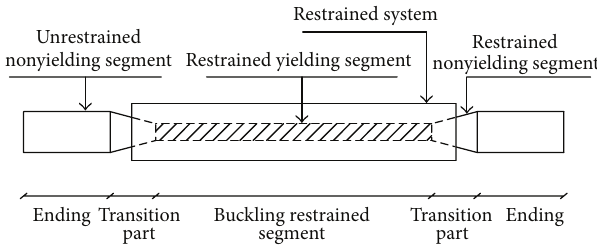
Figure 1: Buckling Restrained Brace (BRB) components [4].